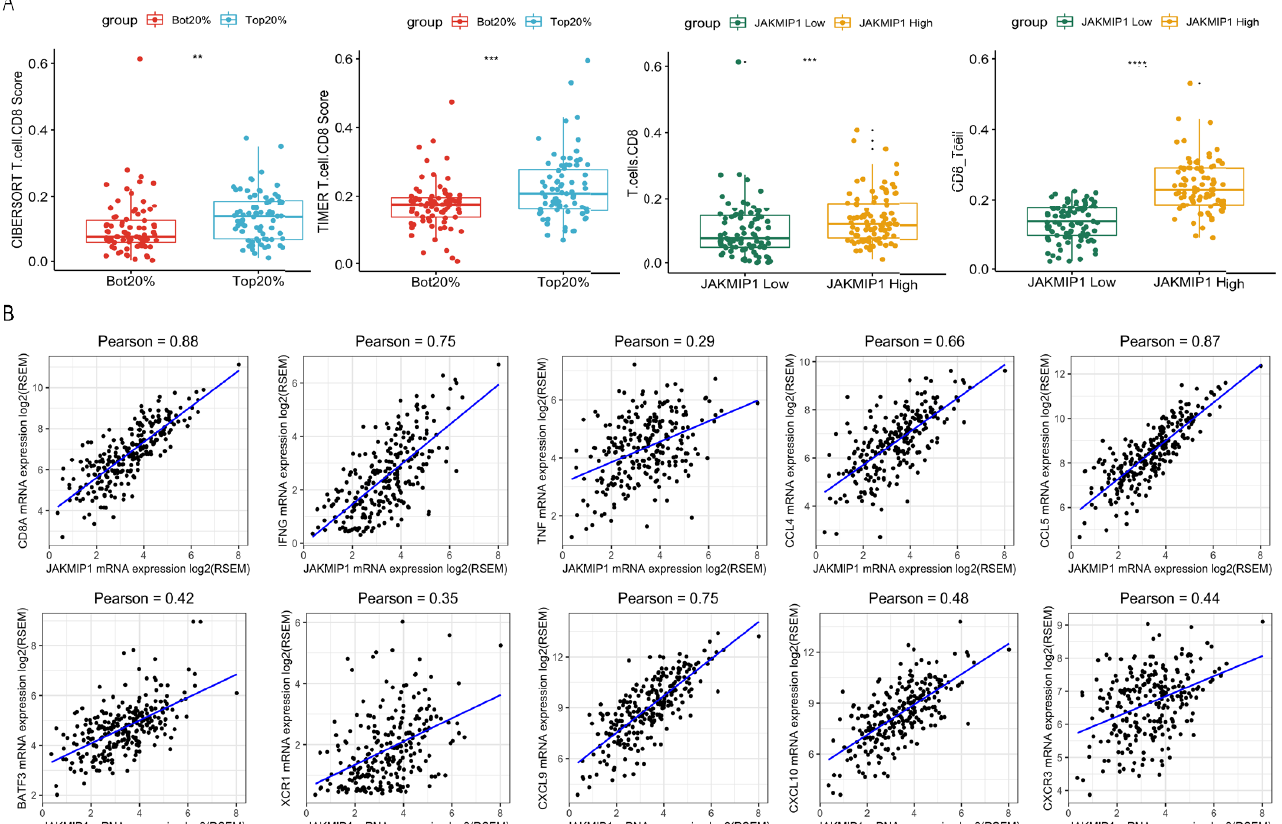
Figure 4. Differentially expressed genes of the high- and low-TMB group related to CD8 + T cell infiltration. ( A ) CD8 + T cell infiltration score of the high- and low-TMB group (left two plots). CD8 + T cell infiltration score of JAKMIP1 high- and low-TMB group (right two plots). ‘**’ means Wilcox test p value < 0.01. ‘***’ means Wilcox test p value < 0.001. ‘****’ means Wilcox test p value < 0.0001.